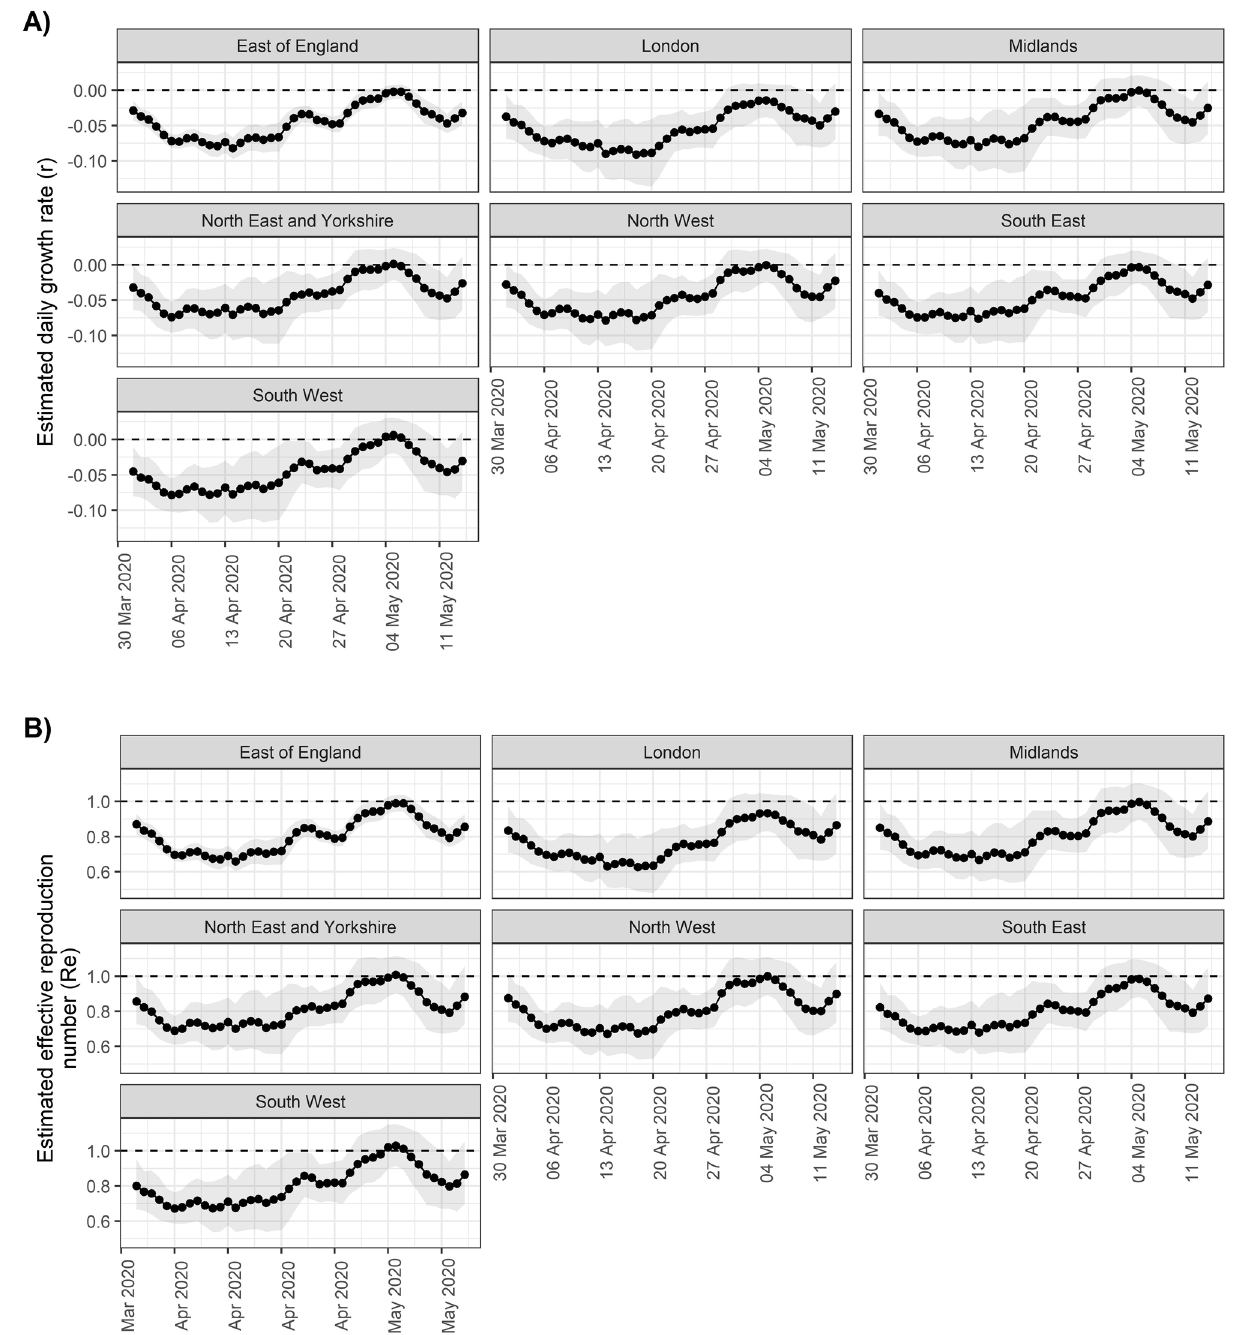
Figure 2. Estimates of ( A ) daily growth rates (r) and ( B ) effective reproduction numbers (R e ) for potential COVID-19 cases reported through NHS Pathways. Dotted lines indicate the central estimate, and ribbons their 95% confidence intervals. Estimates are indicated at the end of the time window used for estimation, so that values of r and R e provided on a given day correspond to the 2 weeks leading up to that